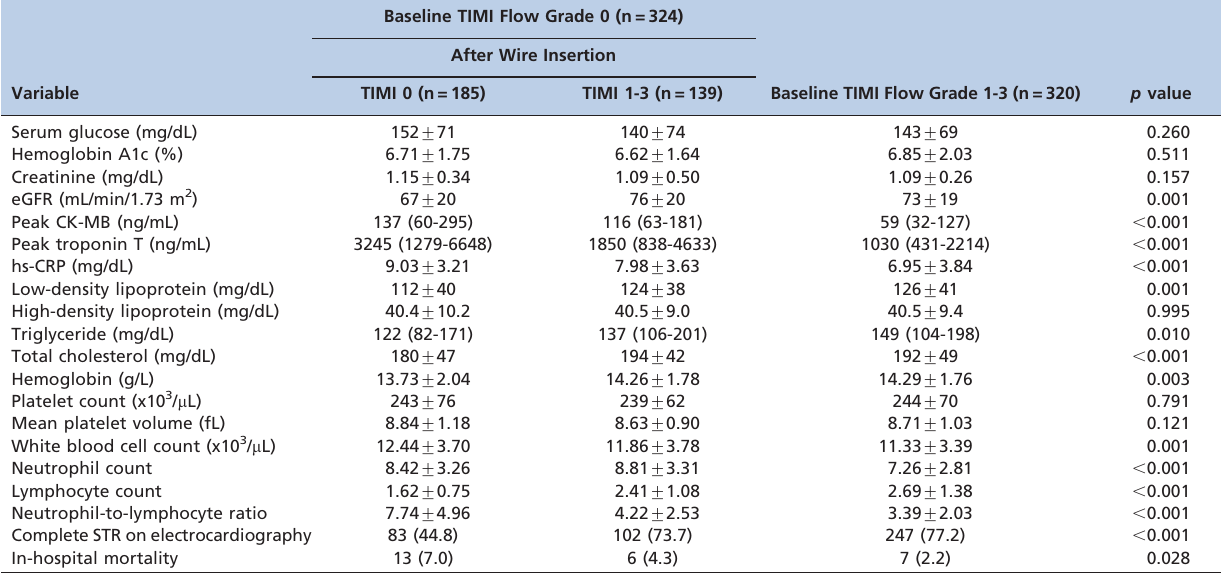
Table 2 - Baseline biochemical and hematologic measurements for the study population. Baseline TIMI Flow Grade 0 (n=324)